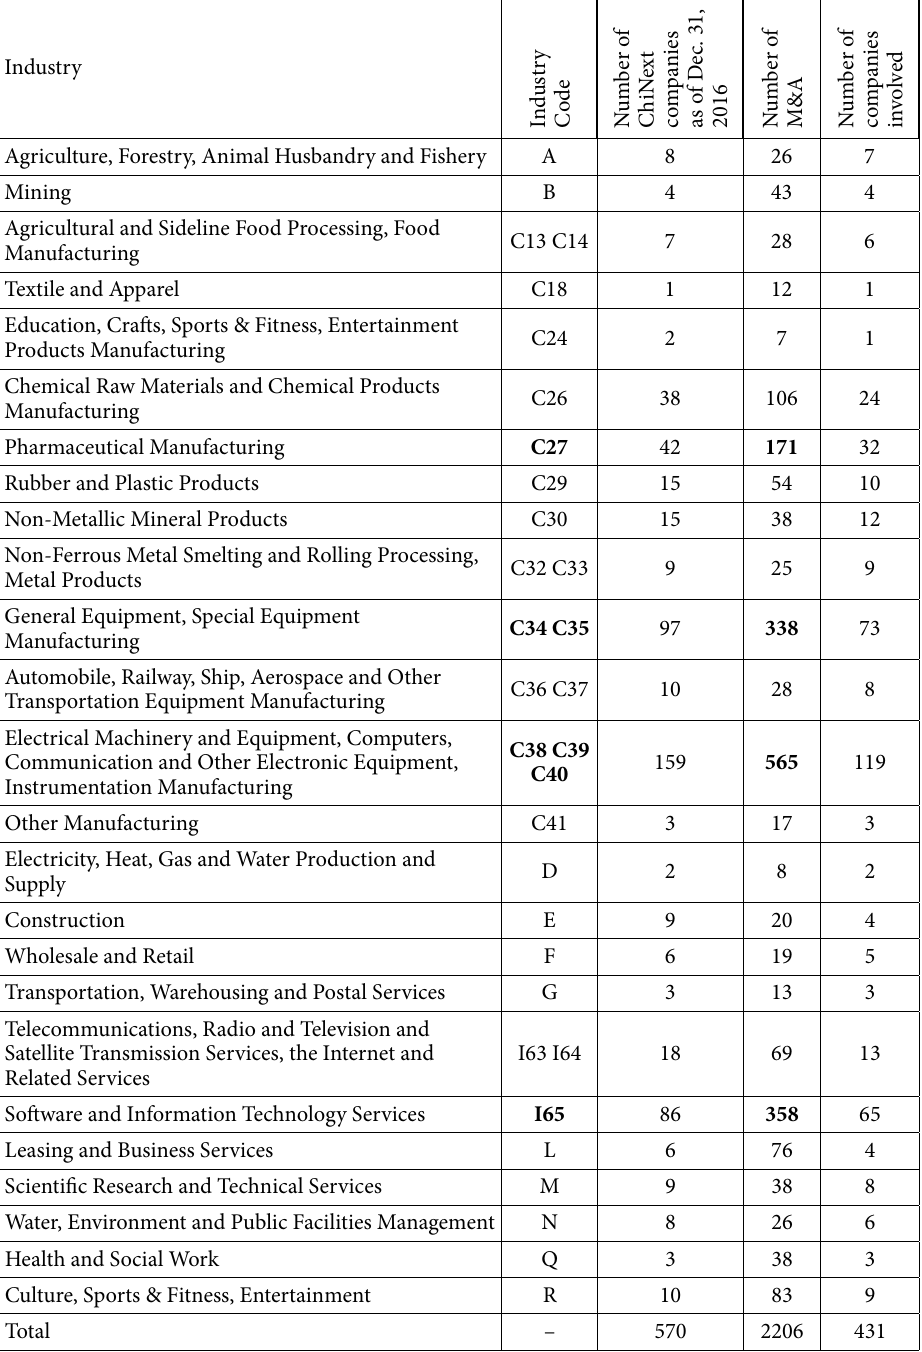
Table 8. Industry distribution of M&A in the ChiNext market